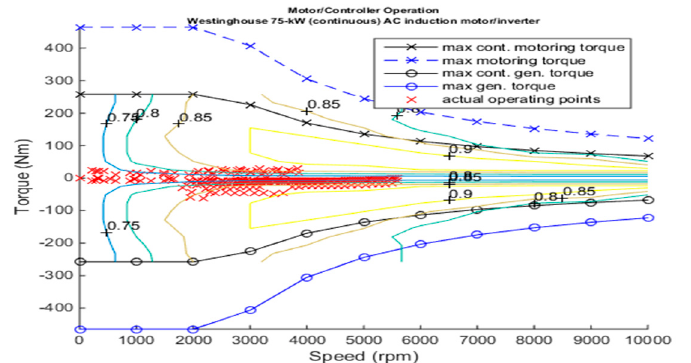
Figure 15. Fuel converter efficiency.